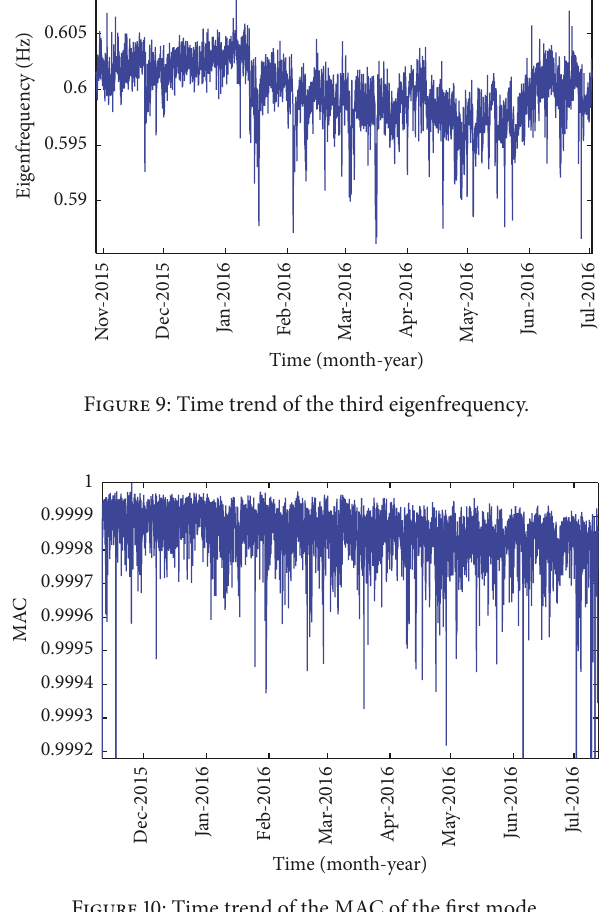
example, sun exposure, temperature, level of the aquifer, and wind speed and direction.